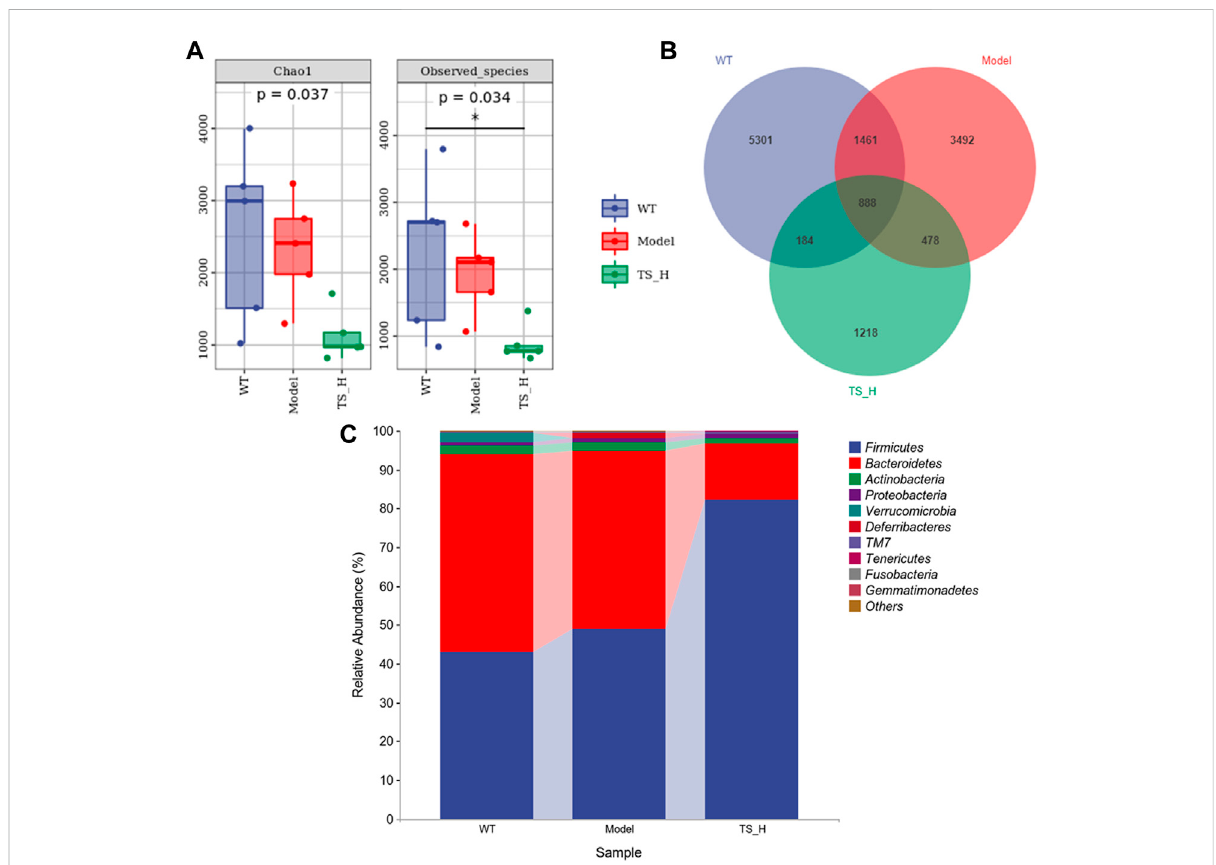
FIGURE 11 Differences in the diversity and composition of gut microbial genes among WT mice, APP/PS1 mice and TS treatment APP/PS1 mice. (A) Alpha diversity analysis-Chao1indexandObservedspeciesindexbox chart. (B) Venndiagram. (C) Columnpicturesofrelativeabundanceand composition of gut microbiota at phylum level in each group. * p < 0.05 versus WT group ( n = 5).